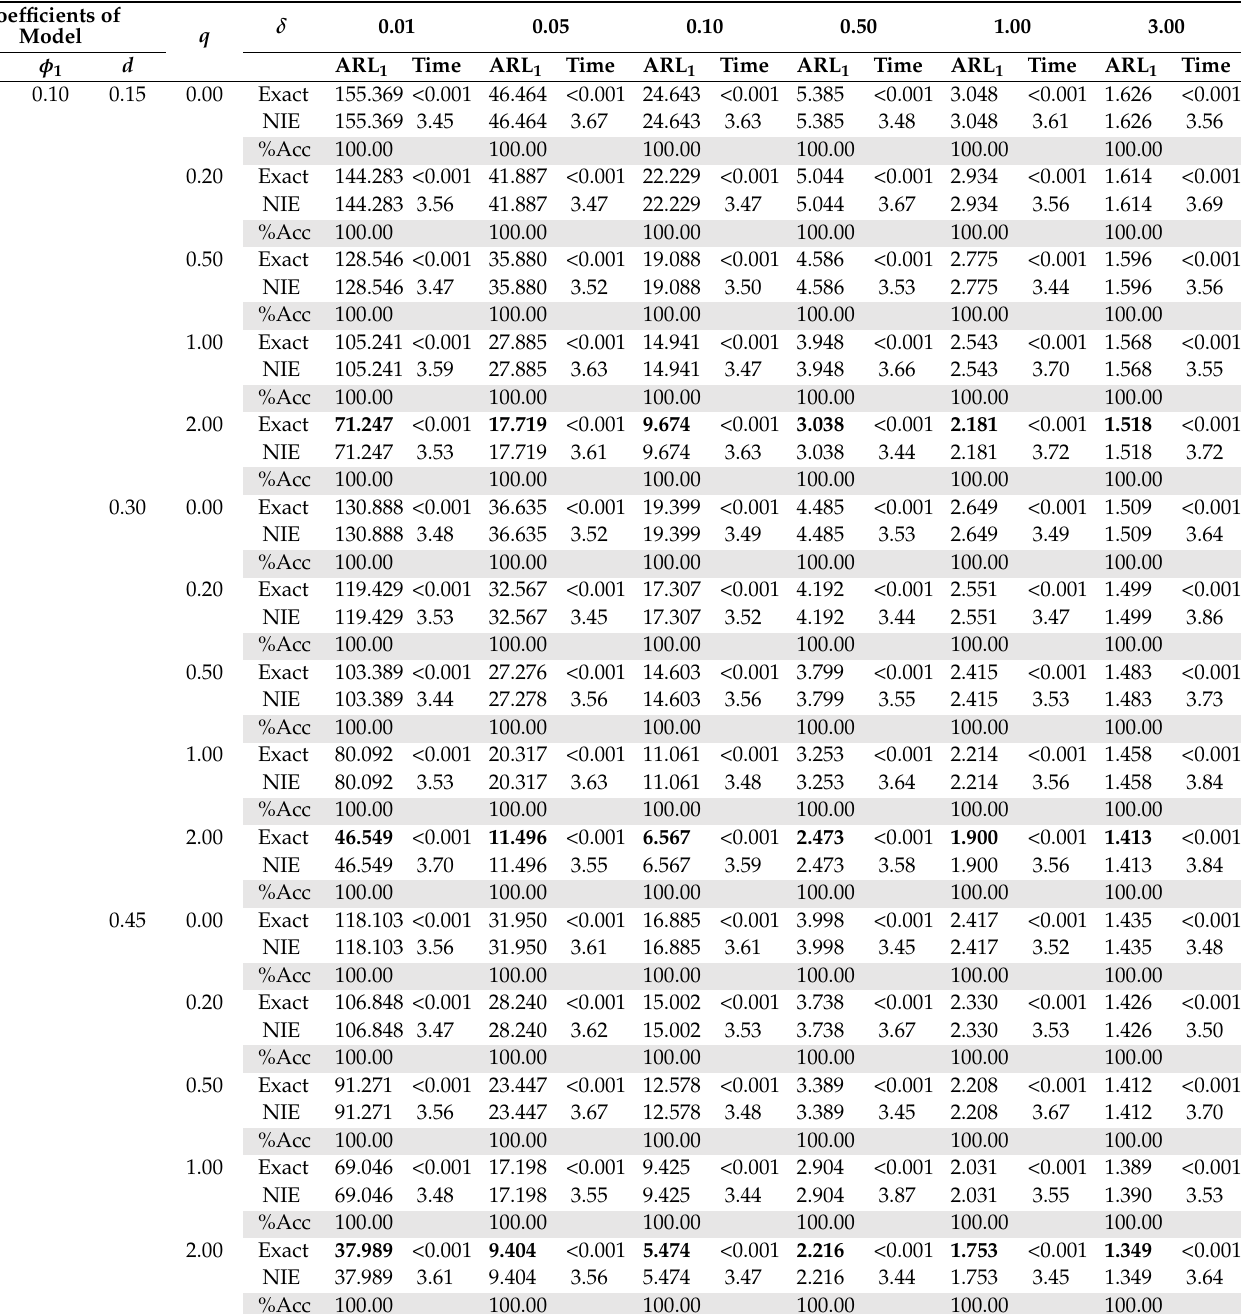
Table 3. The ARL 1 results using the exact formula and the numerical IE technique for ARFI(1, d ) processes running on the modified EWMA control chart with λ = 0.10.